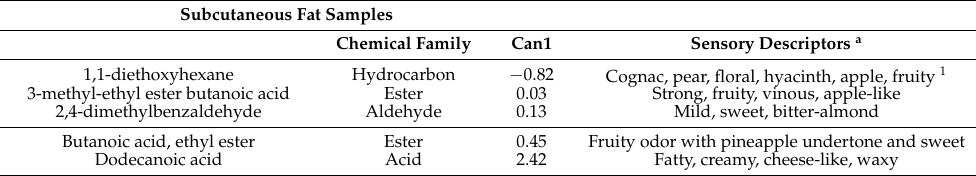
Figure 2. Separation of subcutaneous fat volatile compounds (VOCs) selected by SDA relatively to their capability of correctly differentiating Toscano dry-cured ham samples between low maturing classes (<12 months) and high maturing classes (≥12 months). Table 4. Volatile compounds of subcutaneous fat of Toscano dry-cured ham selected by stepwise discriminant analysis. Canonical discriminant analysis scores (Can1) were used to separate low maturing classes (LMC) and high maturing classes (HMC).